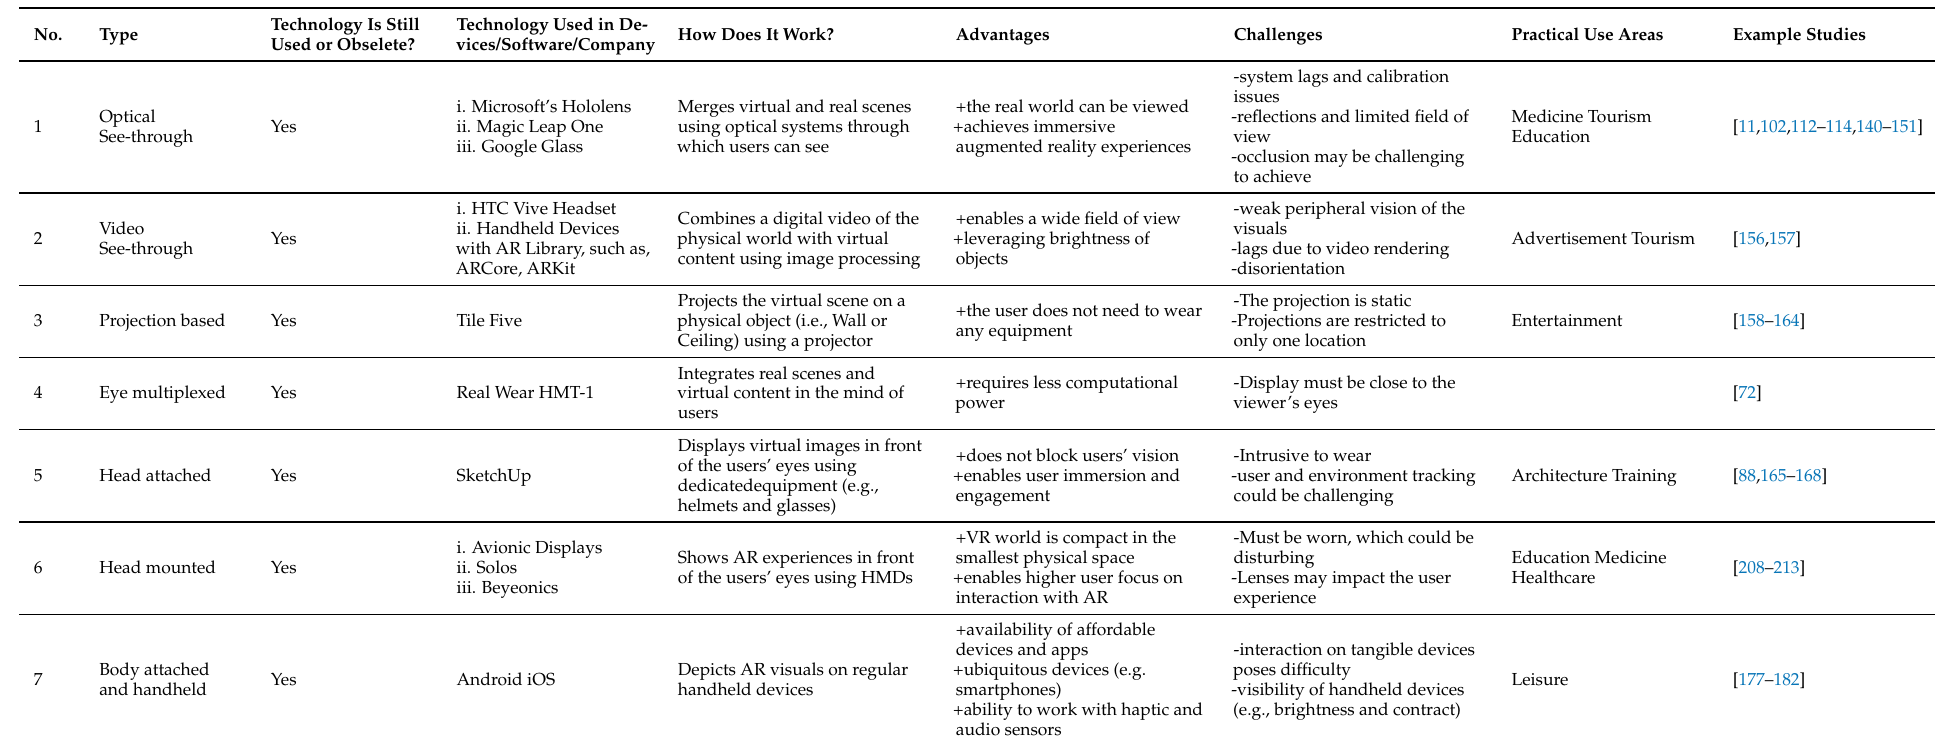
Table 2. A Summary of Augmented Reality Display